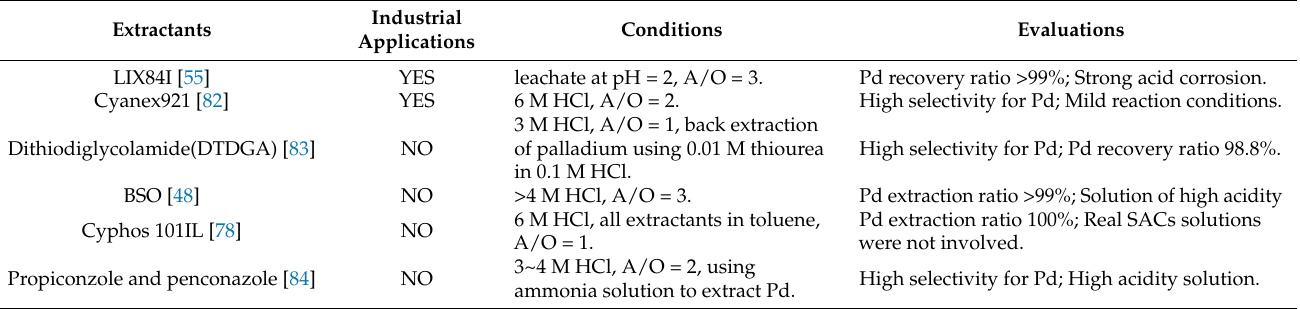
Table 6. Extractants for palladium recovery from the leachate of spent